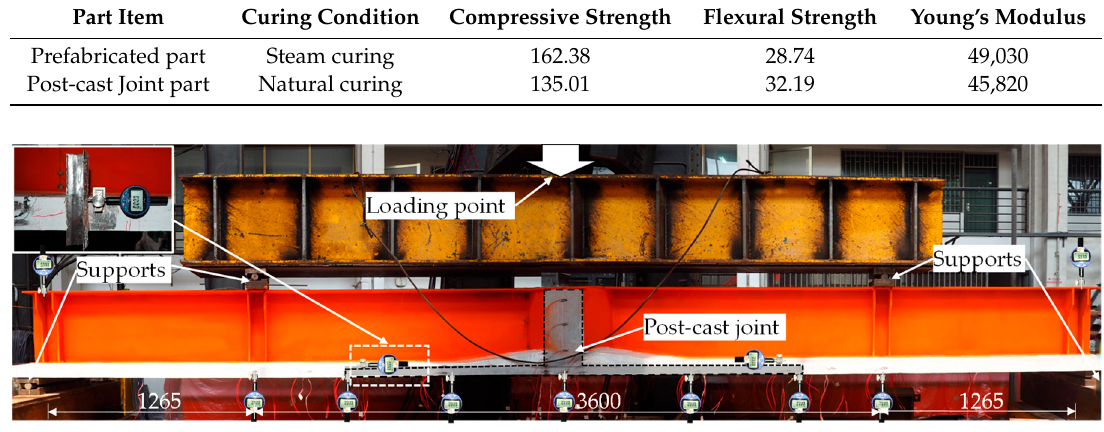
Figure 10. Loading and measuring device.